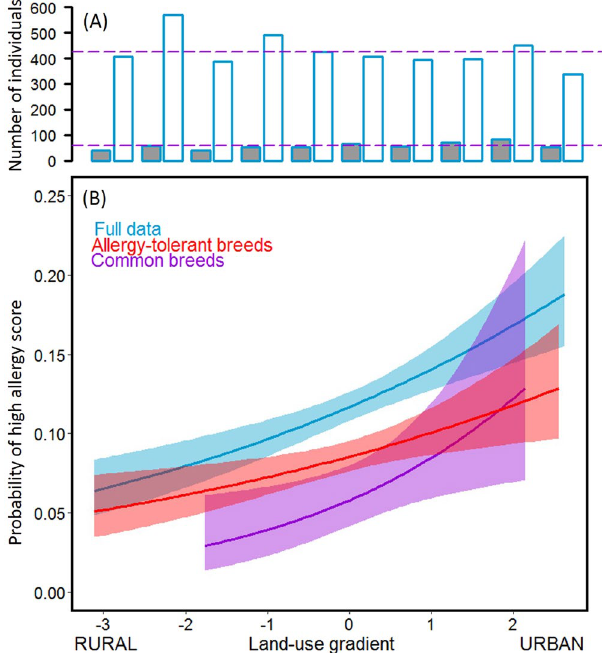
Figure 1. Allergic symptoms are more common in urban environments in dogs. Upper panel (A) shows the number of individuals with a high allergy score (dark grey) and a low allergy score (white) along the land-use gradient in the full data. The purple lines indicate the mean size of high allergy score and low allergy score groups. The proportion of built environment increases along the land-use gradient (x-axis). Lower panel (B) shows the probability of high allergy score along the land-use gradient. The high allergy score is common in urban environments in all subsets i.e. the differing occurrence of breeds in rural and urban environments does not confound the